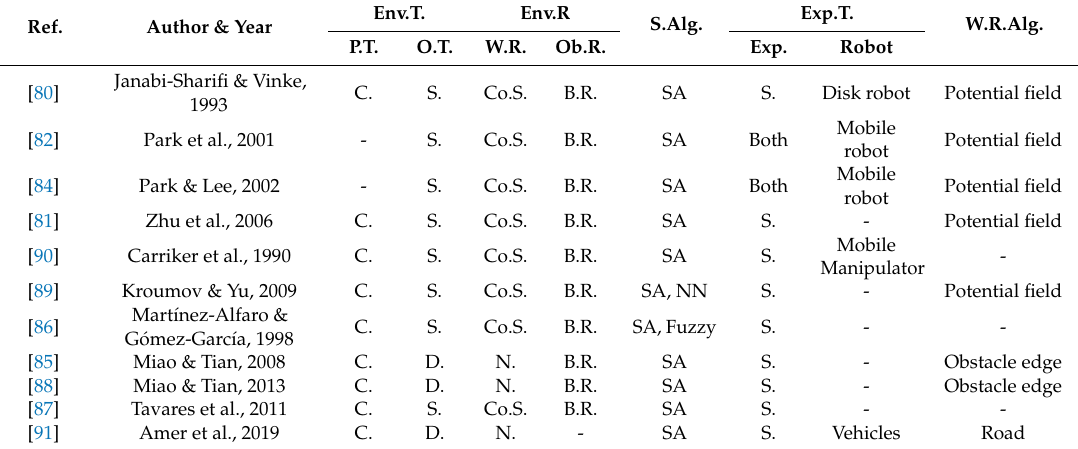
Table 5. Classification of the paper using the heuristic-based algorithm (Simulated Annealing (SA)).